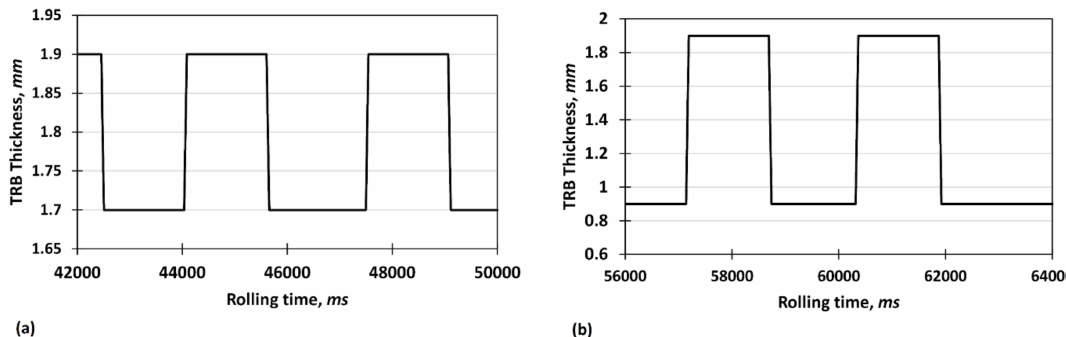
Figure 1. Variations of target thickness with rolling time for ( a ) absolute thickness reduction of 0.2 mm and ( b ) absolute thickness reduction of 1 mm.